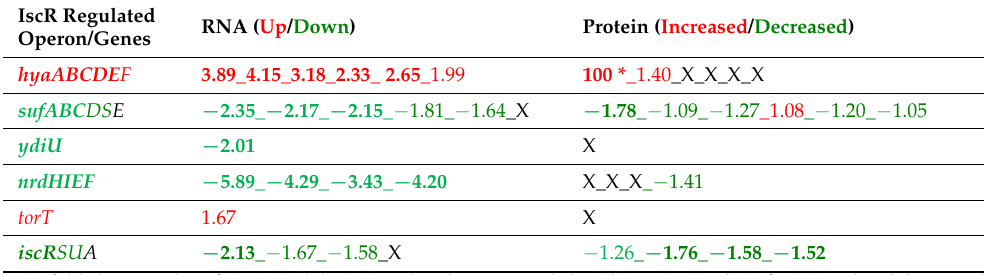
Table 4. Differential expression of genes that belong to the E. coli IscR